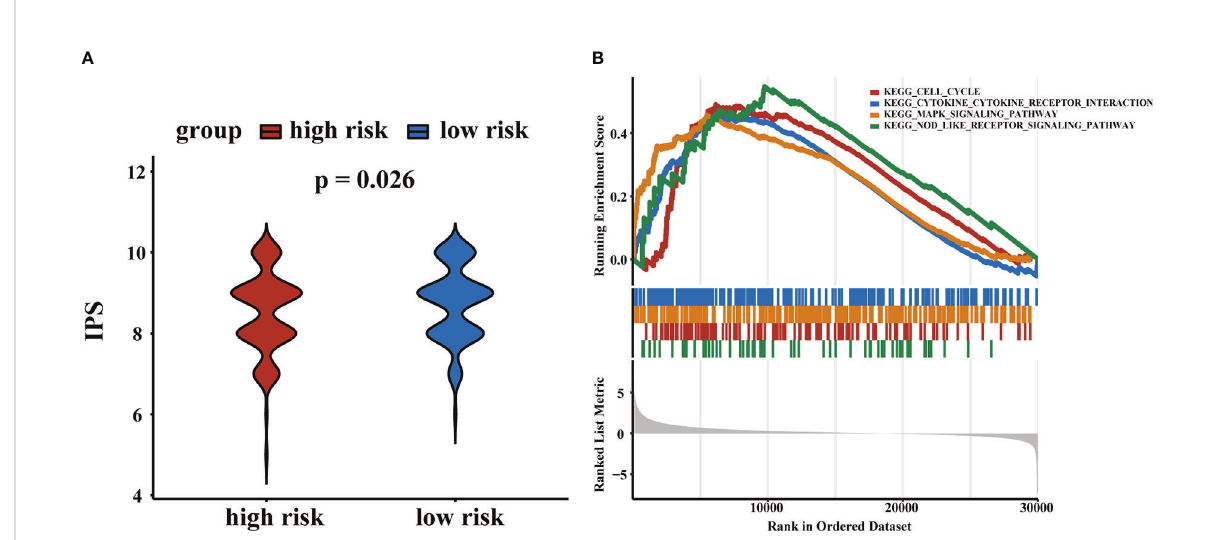
FIGURE 8 Application of RS in chemotherapy and immunotherapy. (A) IPS scores for high-risk and low-risk groups. (B) GSEA